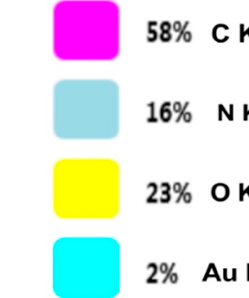
Figure 9. Engineered viscum–AuNPs carrier assembly: SEM—live map.